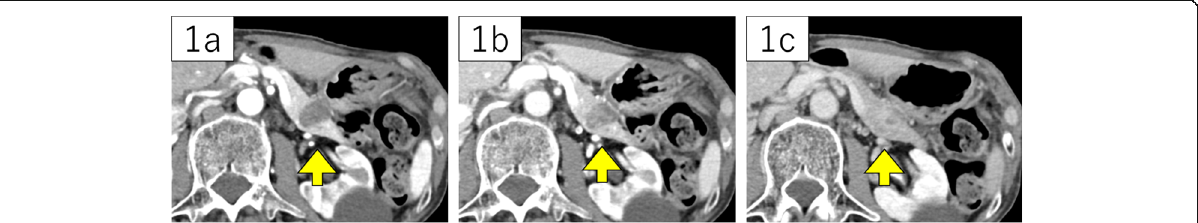
Fig. 1 Dynamic computed tomography (CT) showed hypodensity in the arterial phase ( 1a ), slight enhancement in the portal phase and iso- to hyper-density in the equilibrium phase ( 1b ), compared to the parenchyma of the pancreas ( 1c ), each indicated with arrowheads